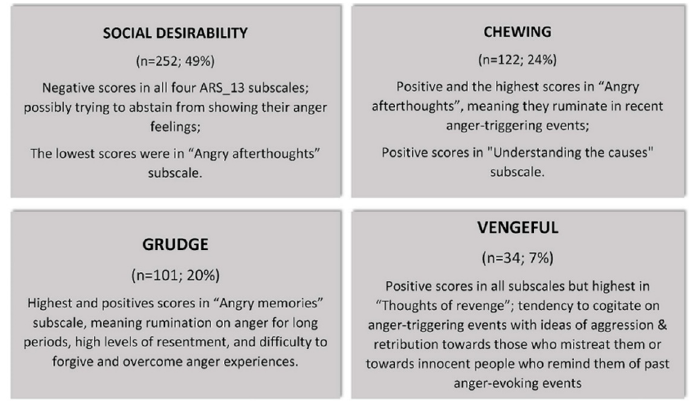
Figure 5. Cluster analysis: description of the four categories.